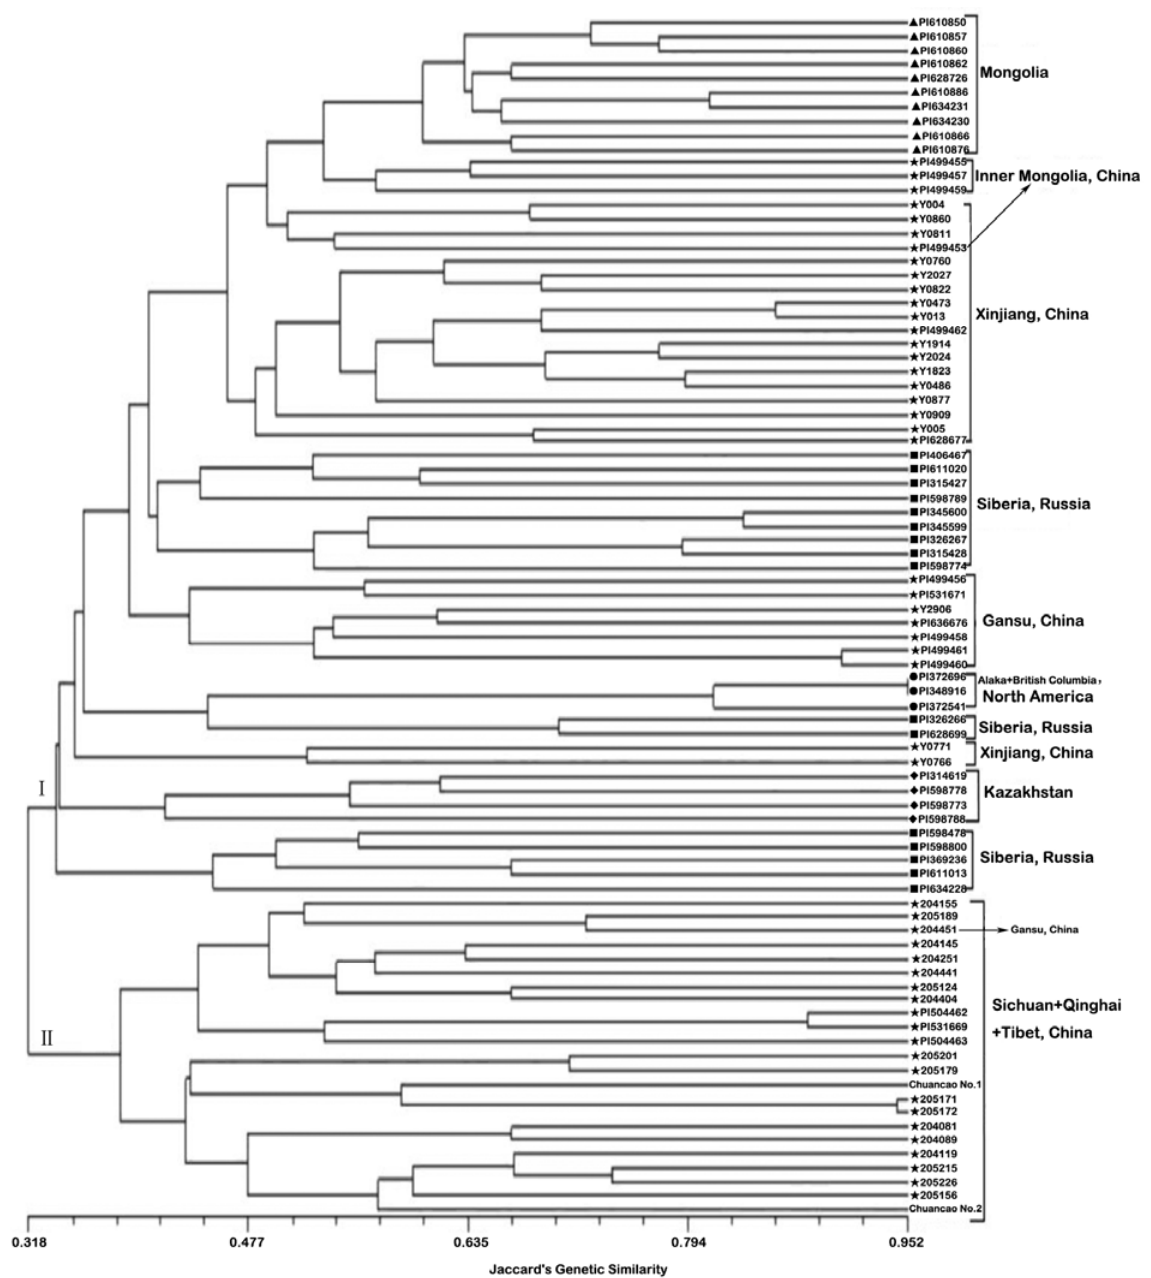
Figure 2. Dendrogram of 86 accessions derived from an UPGMA cluster analysis based on based on Jaccard’s similarity. Symbols show North America ( ● ), Kazakhstan ( ◆ ), Mongolia ( ▲ ), Russia ( ■ ), and China ( ★